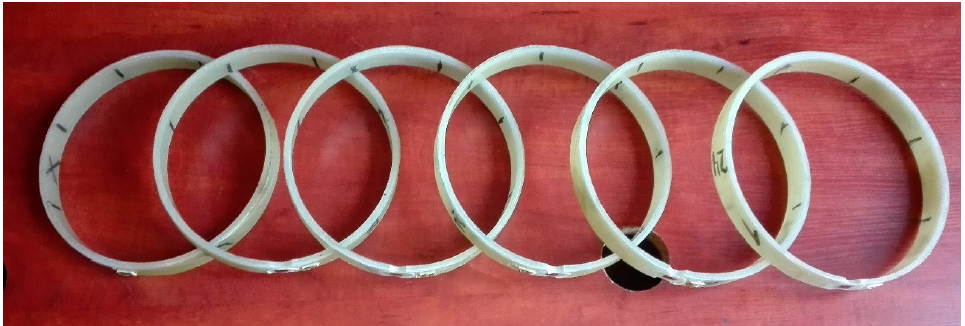
Figure 3. Pipe rims for wall thickness measurements.